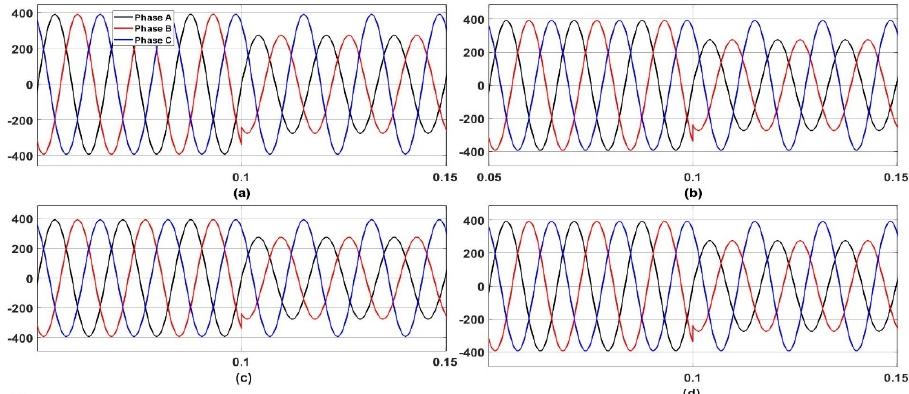
Figure 22. Three-phase pcc voltages in an unbalance dip in the case of ( a ) 2L- αβ , ( b ) 3L- αβ , ( c ) 2L-dq and ( d ) 3L-dq .